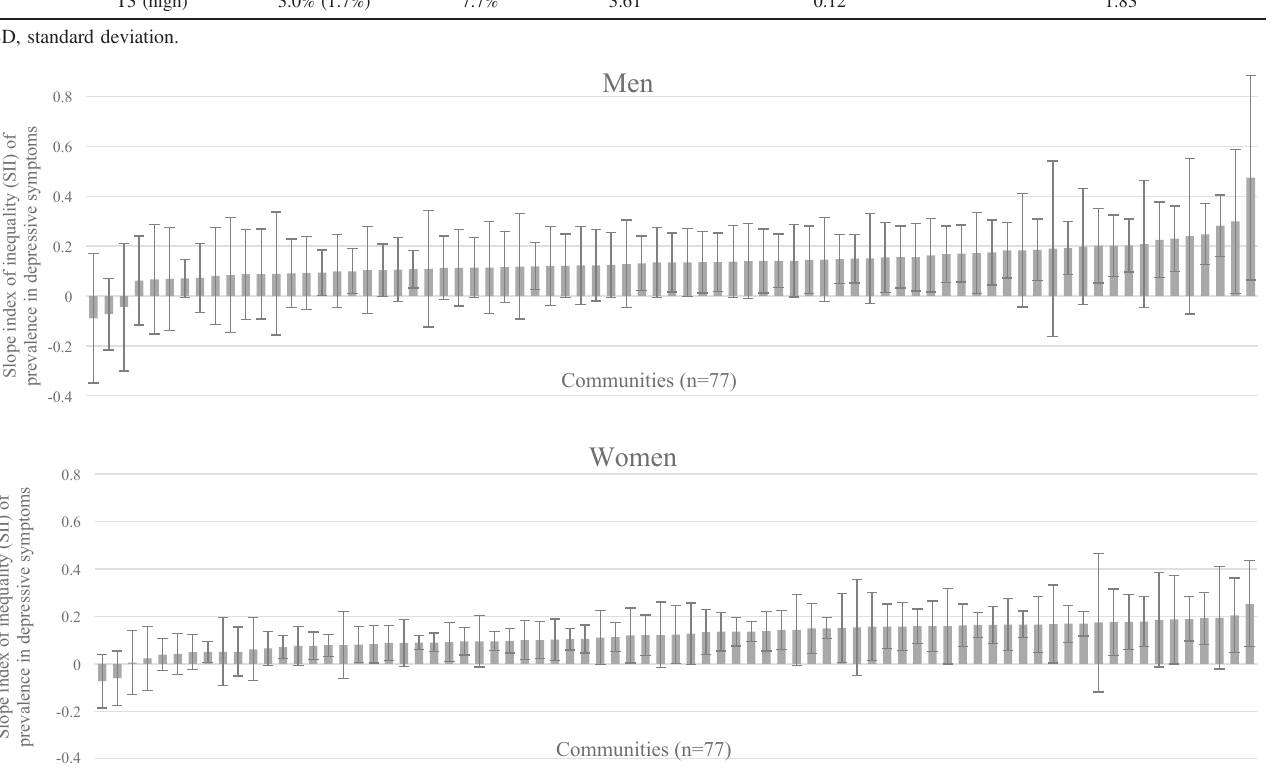
Figure 1. Cross-municipality inequalities of prevalence in depressive symptoms by gender: Slope Index of Inequality (SII) . Error bars indicate 95% Con fi dence